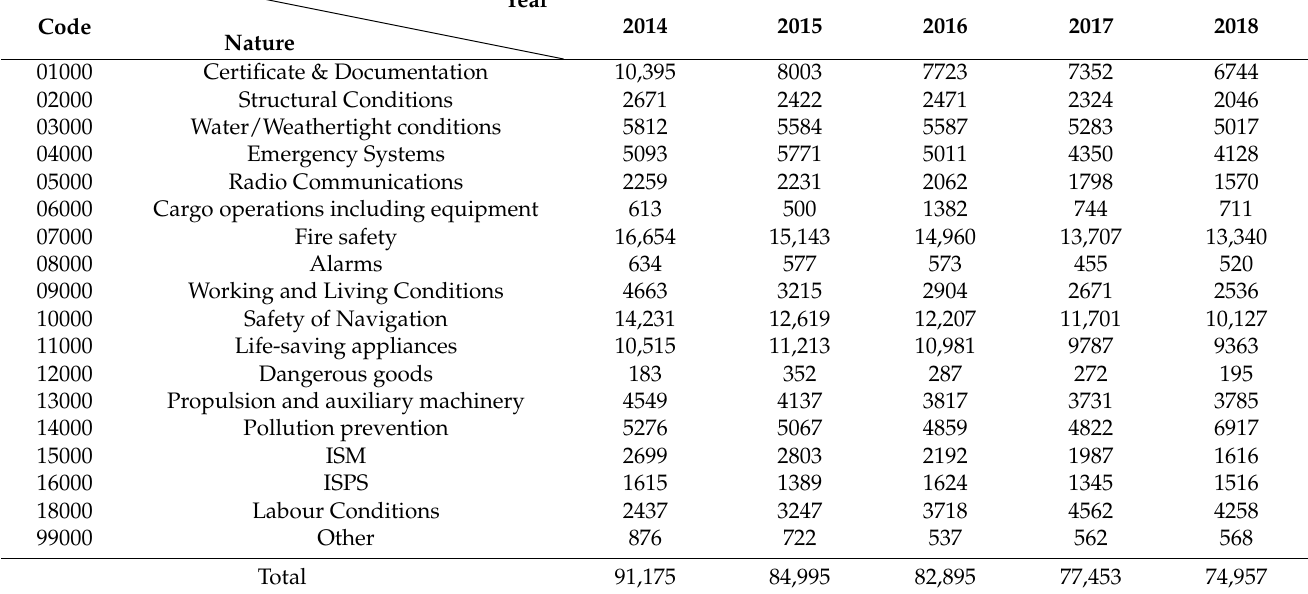
Table A1. Statistics on the deficiencies registered by the flags of the ships in the Tokyo MoU from 2014 to 2018. Code